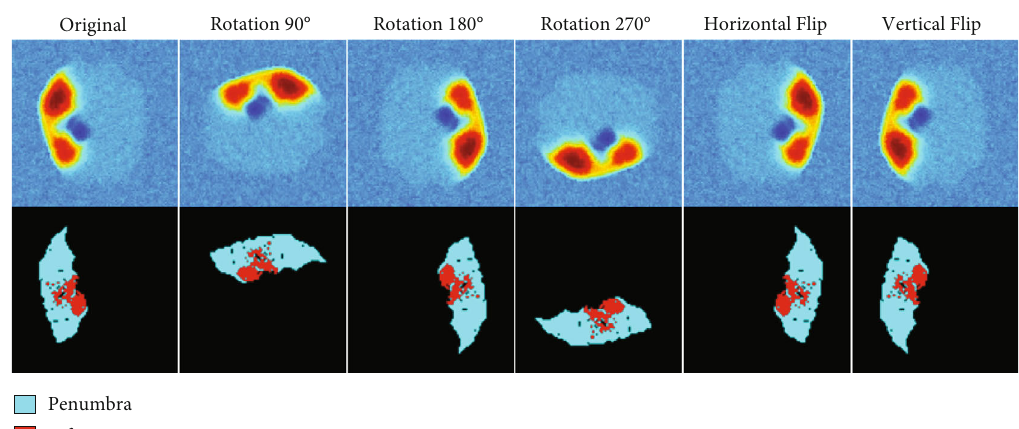
Figure 2: Data augmentation used to improve the network performance by increasing the size of training dataset using new images generated arti fi cially from the existing images in the dataset. Left: the original thermal image with ground truth. The rest are rotated and fl ipped versions of the original thermal